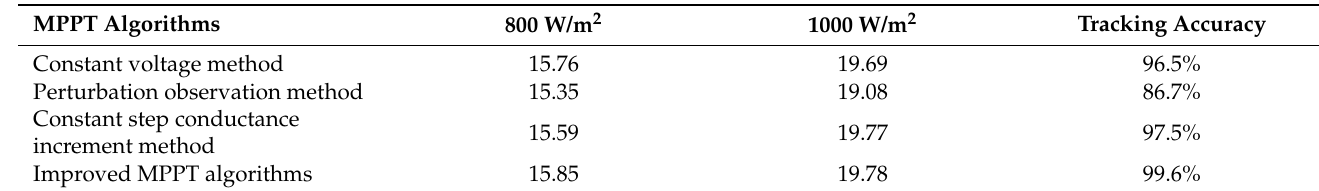
Table 5. Comparison of Average Power at Constant Light